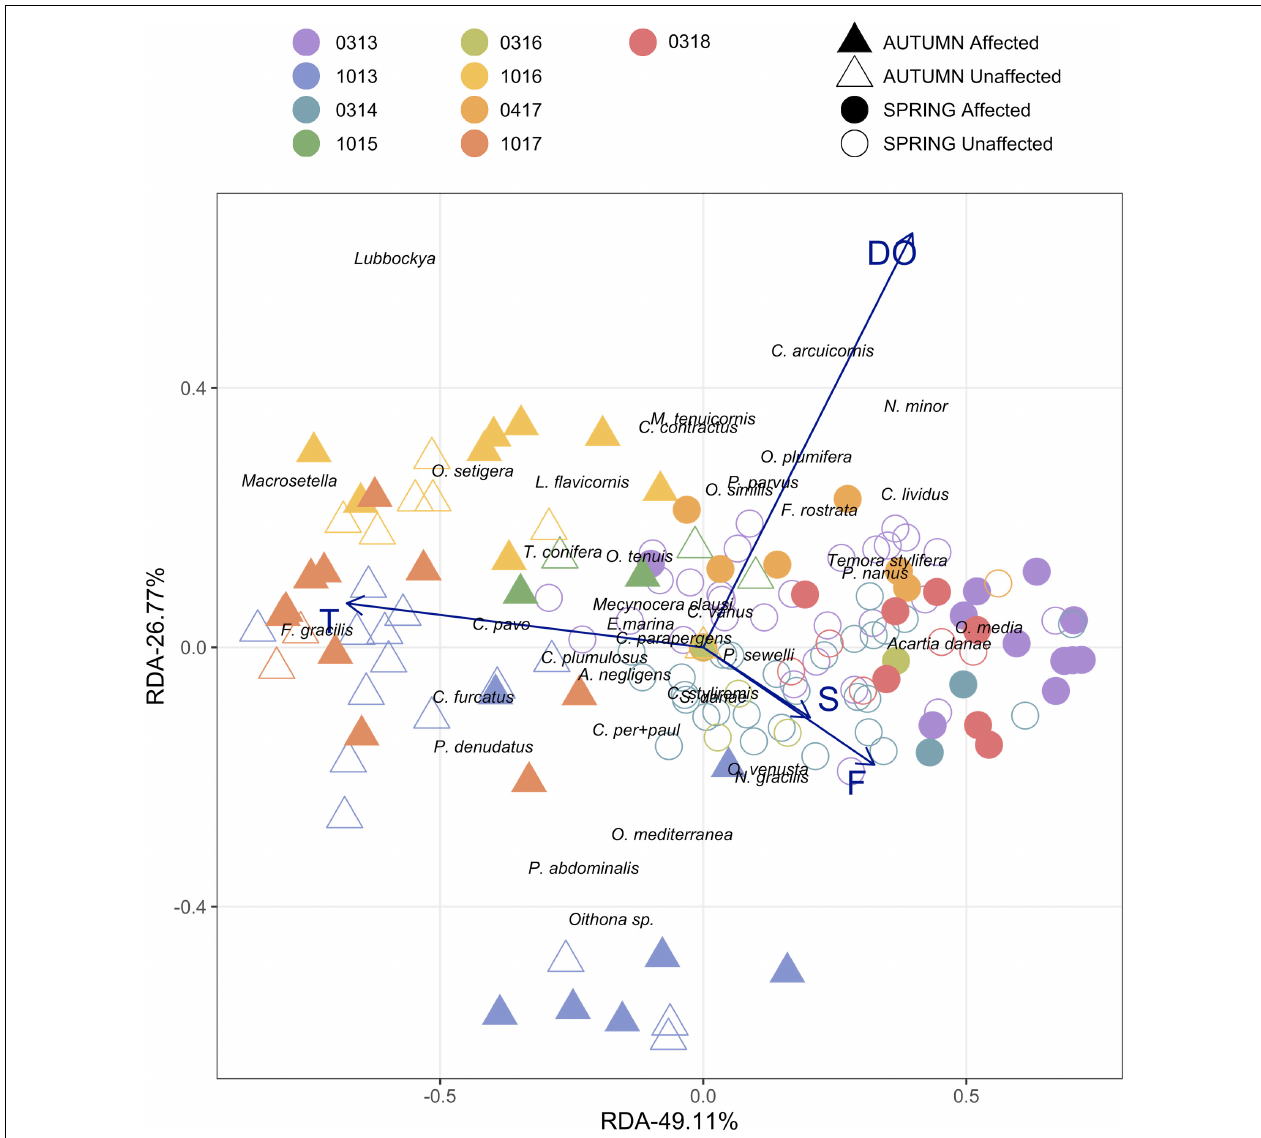
FIGURE 9 | Redundancy Analyses of the dominant species ( > 1.5%) and main environmental variables: Temperature 0-200 (T). Fluorescence 0-100 (F). Salinity 0-200 m (S) and Dissolved Oxygen 0-200 m (DO). Dots indicate the 160 samples conducted at the different surveys during spring vs. autumn seasons, considering both stations affected by the volcano and their unaffected